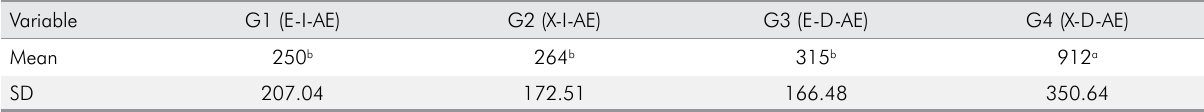
Table 1. Mean and standard deviation of the number of open dentinal tubules (per 14.4 mm 2 ), according to the cleaning solutions and acid etching time-point used.